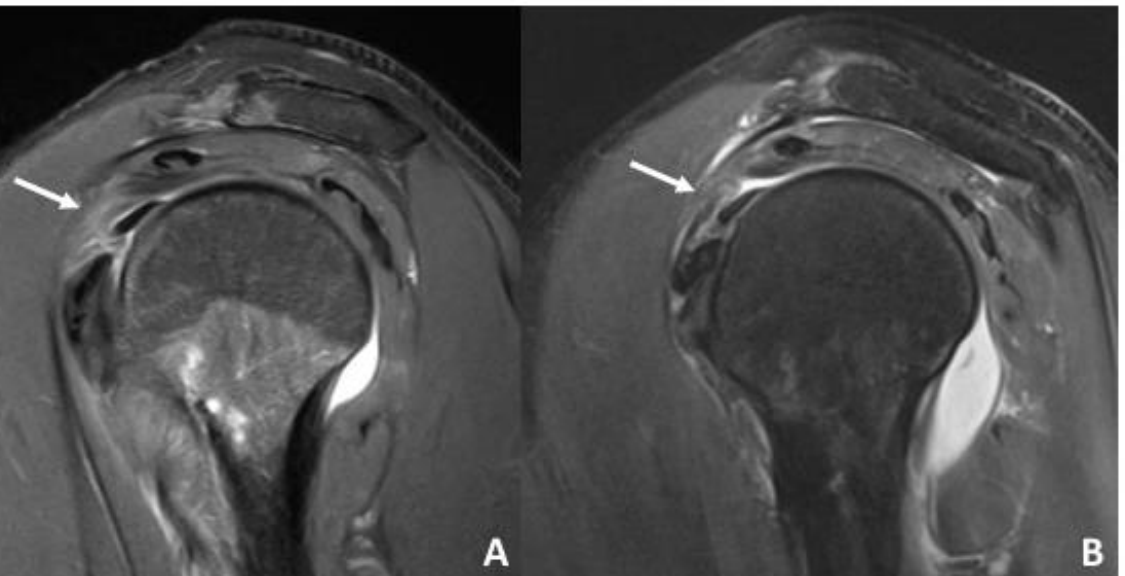
Figure 2. ( A ) Transversal IM-weighted TSE sequence with spectral fat saturation of a 45-year-old patient after traumatic shoulder dislocation with antero-inferior labral lesion and concomitant me- dial subluxation of the LHBT (white arrow) due an insufficient biceps pulley and a partial SSC ten- don tear. ( B ) Sagittal IM-weighted TSE sequence with spectral fat saturation. Pulley lesion in a 39- year-old patient after traumatic anterior shoulder dislocation with tear of the sGHL and CHL. Note the displacement of the LHBT (white arrow) as well as the tendinopathic changes which might be due to preexisting degenerative changes.